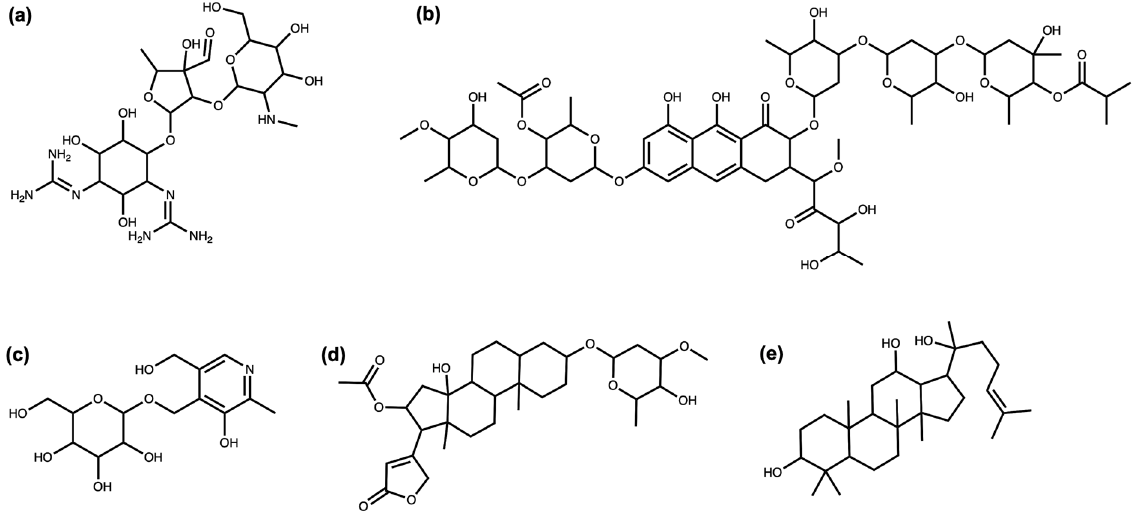
Figure 1. ( a ) Streptomycin. ( b ) Olivomycin A. ( c ) 4’-O-(beta-D-Glucopyranosyl)pyridoxine. ( d ) Oleandrin. ( e ) (20S)-Pro- topanaxadiol.